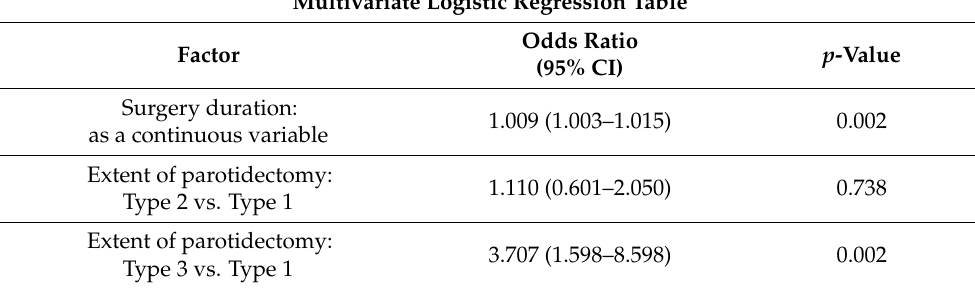
Table 8. Multivariate logistic regression for facial paralysis occurrence after parotidectomy (surgical procedures: n =